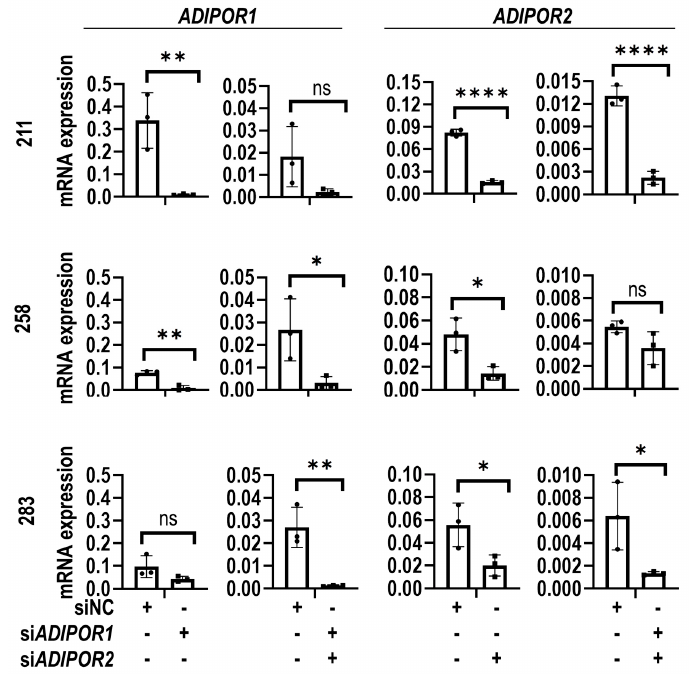
Figure 3. Depletion of adiponectin receptor 1 ( ADIPOR1 ) and ADIPOR2 in MSCs. RT-qPCR data show mRNA expression levels of ADIPOR1 and ADIPOR2 upon transfection with non-silencing control (siNC), or siRNAs for ADIPOR1 (si ADIPOR1 ), ADIPOR2 (si ADIPOR2 ) or the combination of ADIPOR1 and ADIPOR2 (si ADIPOR1 +si ADIPOR2 ) in MSCs derived from three distinct donors (211, 258 and 283). Statistical difference in gene expression between groups is shown with brackets. Asterisks indicate differences in probability values: p ≤ 0.0001 = ****; p ≤ 0.01 = **; p ≤ 0.05 = *; p > 0.05 = not significant (ns). Statistical significance and error bars (mean ± standard deviation) are based on n = 3 biological replicates for each of the three MSC donors (data points superimposed on the graphs). The biological effects of si ADIPOR1 and si ADIPOR2 treatment on the metabolic activity of MSCs were examined by MTS assays. The results show that transfection of ADIPOR1 and ADIPOR2 siRNAs did not have appreciable effects on cellular metabolic activity (Figure 4).